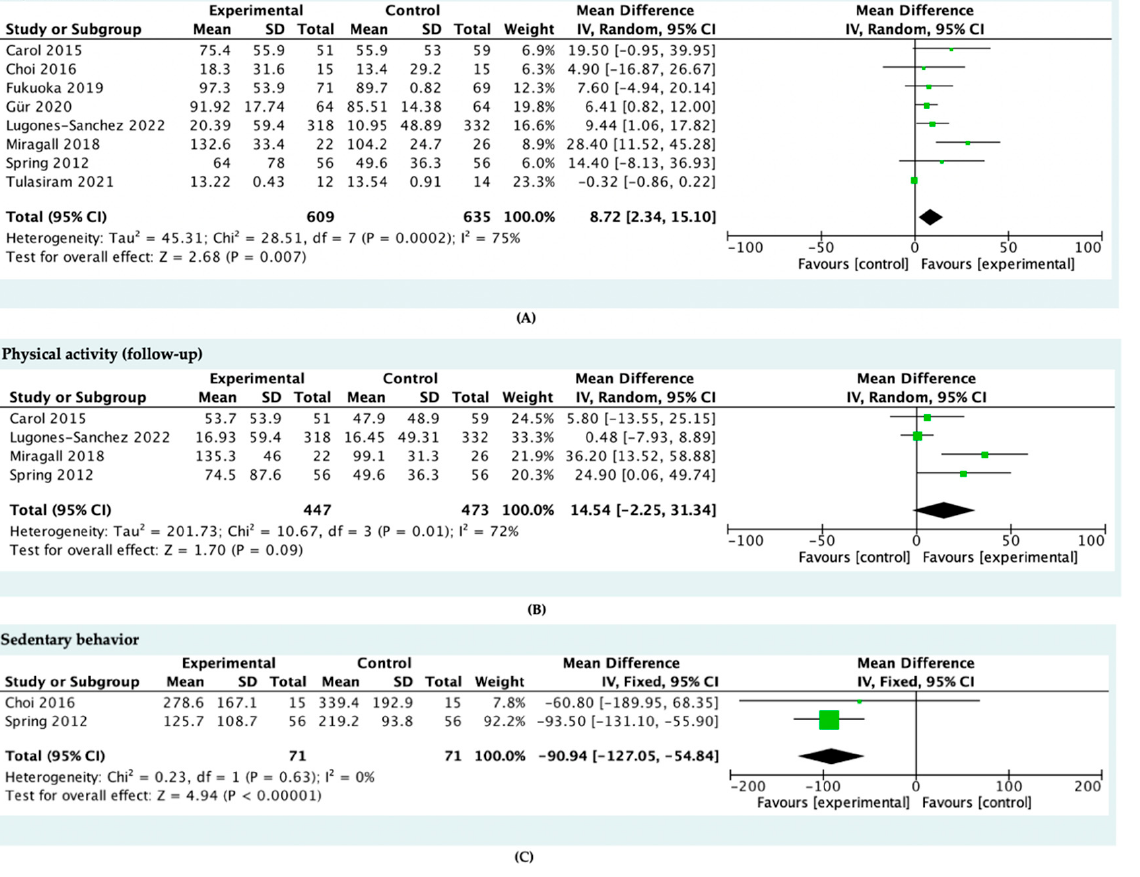
Figure 3. Meta-analysis of the effect of mobile health applications among the inactive population on ( A ) physical activity, ( B ) physical activity follow-up, and ( C ) sedentary behavior.